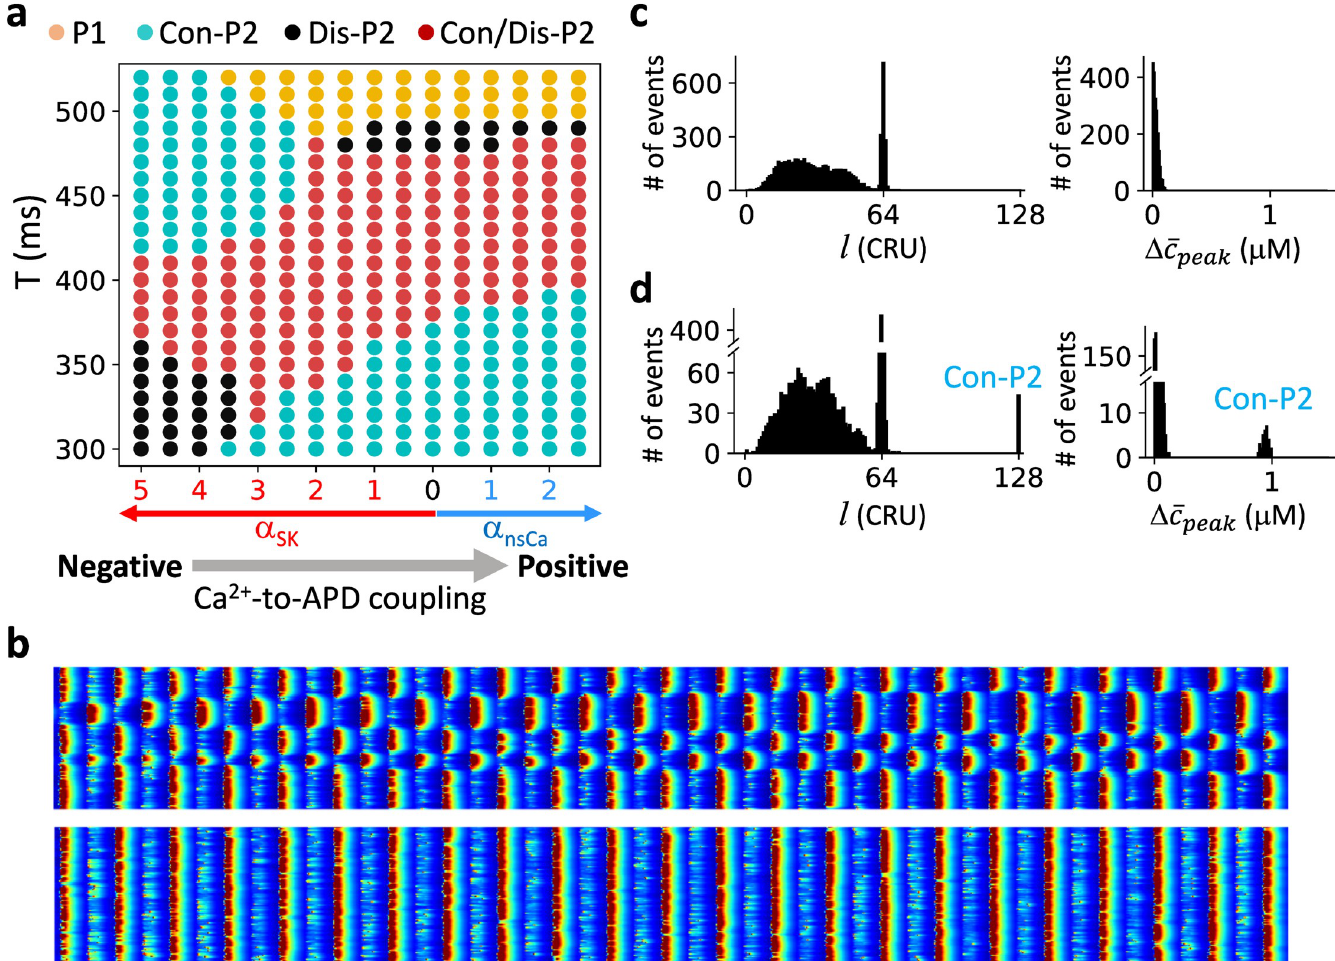
Fig 5. Ca 2+ release pattern dynamics in the ventricular myocyte model with positive and negative Ca 2+ -to-APD coupling. a . Phase diagram of Ca 2+ release dynamics versus pacing period and Ca 2+ -to-APD coupling properties. In this diagram, the x-axis is the fold increase of either I nsCa (blue arrow) or I SK (red arrow), and the y-axis is the pacing period T. Gray arrow indicates the change from negative to positive Ca 2+ -to-APD coupling. Same color codes of the pattern dynamics as in Fig 3A were used. b . A Dis-P2 pattern (upper) and a Con = P2 pattern (lower) for α SK = 3.5 and T = 350 ms obtained with two different initial conditions. c . Left: Histogram of domain size l . The pacing period T = 330 ms, α = 4.5, The random initial conditions were set the same way as in Fig 4 with Δ Ca SK were performed. For each trial, the cell was paced 2000 beats to reach a steady state. The domain size was computed using the last 50 beats. Right: Histogram of global P2 amplitude D � c from the same simulations. D � c was measured using the last two beats. d . Same as panel c but T = 350 ms and α peak peak